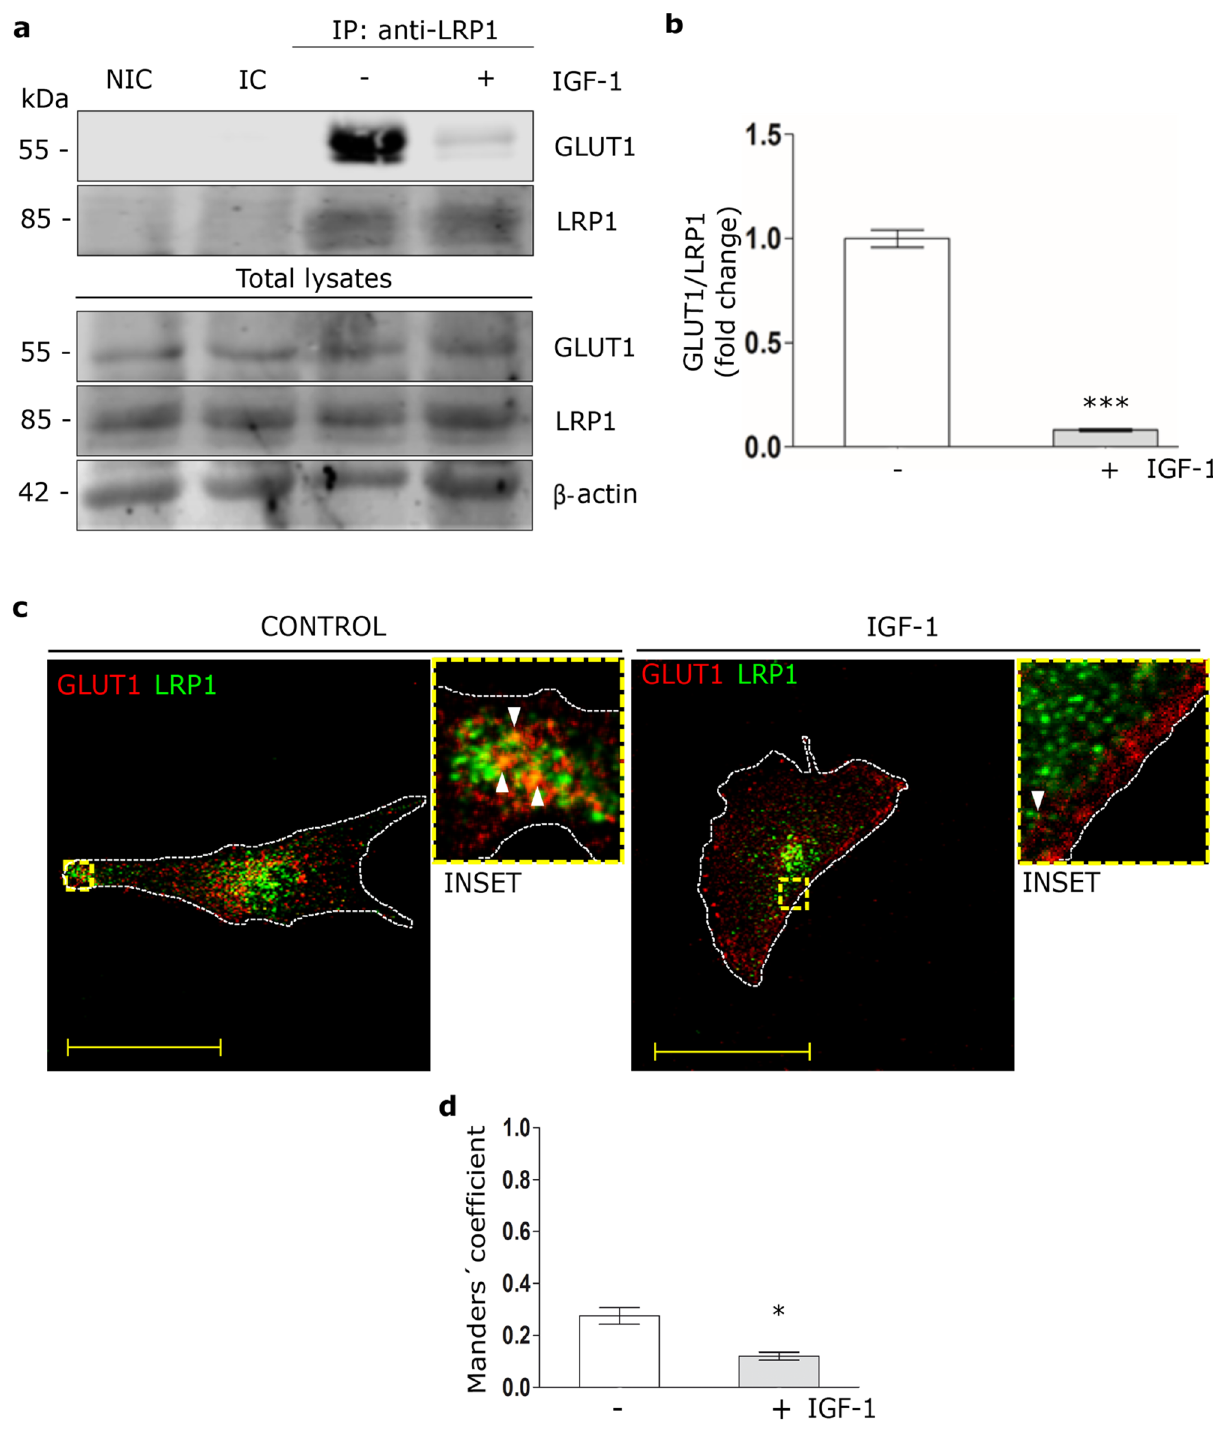
Figure 4. IGF-1 reduces the molecular association between LRP1 and GLUT1. ( a ) Immunoprecipitation assays in MIO-M1 cells treated with IGF-1 10 nM for 30 min. Cell lysates were immunoprecipitated with anti-LRP1 antibody and protein A/G agarose beads as indicated in Methods. Immunoprecipitated LRP1 and GLUT1 are shown on the top panel and total LRP1, GLUT1 and β-actin in cell lysates are shown in the lower panel of the Western blot. NIC: non-immune control. IC: isotype immunoglobulin control. ( b ) Densitometric quantification of relative intensity of GLUT1 bands with respect to LRP1 as a fold change against control (white bar). Values are expressed as mean ± SEM. *** p < 0.001 versus non-stimulated control. Three independent experiments in duplicate were performed (n = 6). ( c ) Confocal microscopy in MIO-M1 cells treated with IGF-1 10 nM for 30 min. Representative images of LRP1 (green) and GLUT1 (red) in immunostained sections. INSET represents magnification 4× of framed regions in dotted lines. White arrowheads indicate colocalization sectors (yellow). Images are representative of 20 cells per condition (n = 20). White dotted line represents the cell shape. Scale bar = 15 μM. ( d ) Quantitative analysis of colocalization between LRP1 and GLUT1 by Manders’ coefficients are expressed as mean ± SD (%) measured in 20 cells per condition from three independent experiments. * p < 0.05 versus non-stimulated control (white